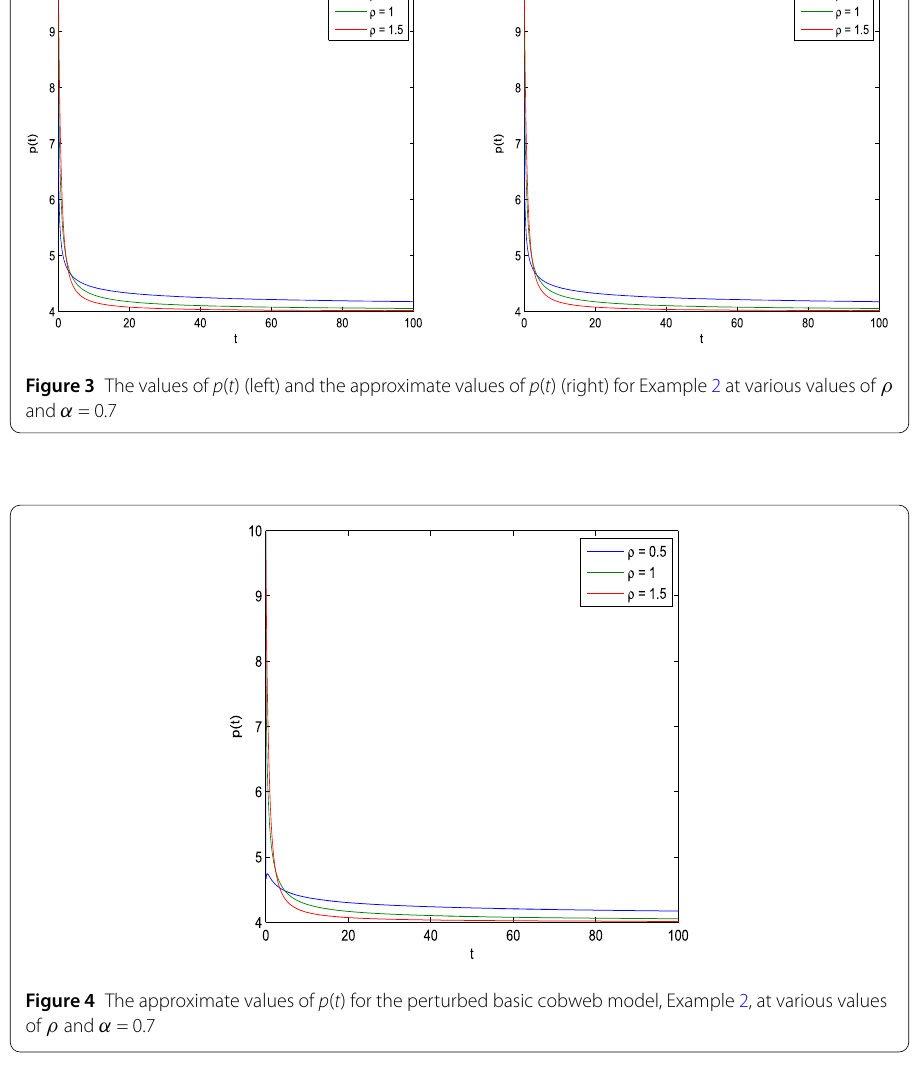
Acknowledgements Not